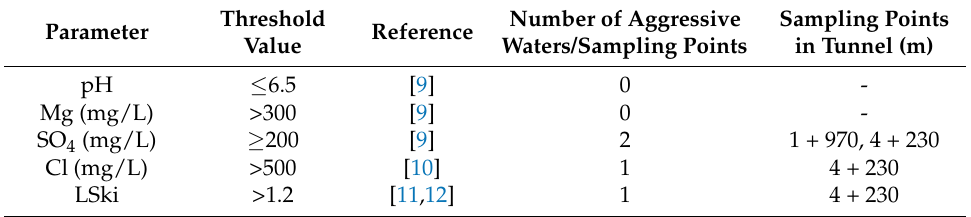
Table 4. Classification of the aggressiveness of groundwater sampled from HPP Pirot tunnel.